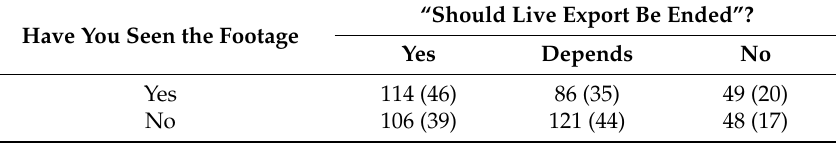
Table 3. The relationship between viewing footage and attitude to live export (Odds Ratio for Yes